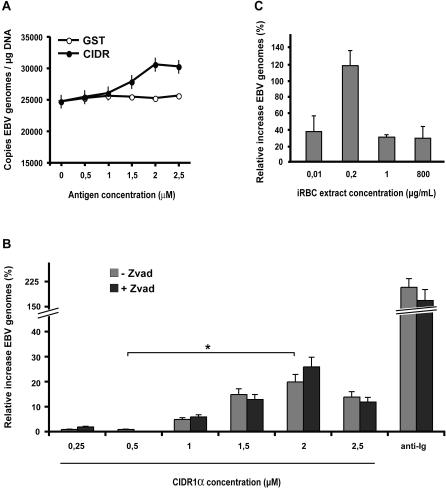
CIDR1α and iRBC Stimulation Lead to Increased Viral Load in Akata Cells(A) Akata cells were cultured in medium alone (referred to as Ag concentration 0) with GST (white circles) or with CIDR1α (black circles) at protein concentrations ranging from 0,5 to 2,5 μM in the presence or absence of zVAD. After 48 h of incubation, the viral genome copy number was determined by real-time PCR. Results from a representative experiment (out of four independent experiments) are expressed as numbers of EBV genome copies per μg of total DNA.(B) Akata cells were cultured with GST or CIDR1α (0–2,5 μM), and with anti-Ig (10 μg/mL). After 48 h of incubation, the viral genome copy number was determined by real-time PCR. Results are expressed as percentage of relative increase in EBV copy number in cultures stimulated with CIDR1α versus cultures stimulated with GST, and represent the mean of four independent experiments ± standard deviation. *, p
2vs0,5 μM  = 0,03.(C) Akata cells were cultured with increasing concentrations of crude extracts from iRBCs and RBCs. After 48 h of incubation, the viral genome copy number was determined by real-time PCR. Results from one representative experiment (out of three performed) are expressed as percentage of relative increase in EBV copy numbers in cultures stimulated with iRBCs versus cultures stimulated with RBC extracts.